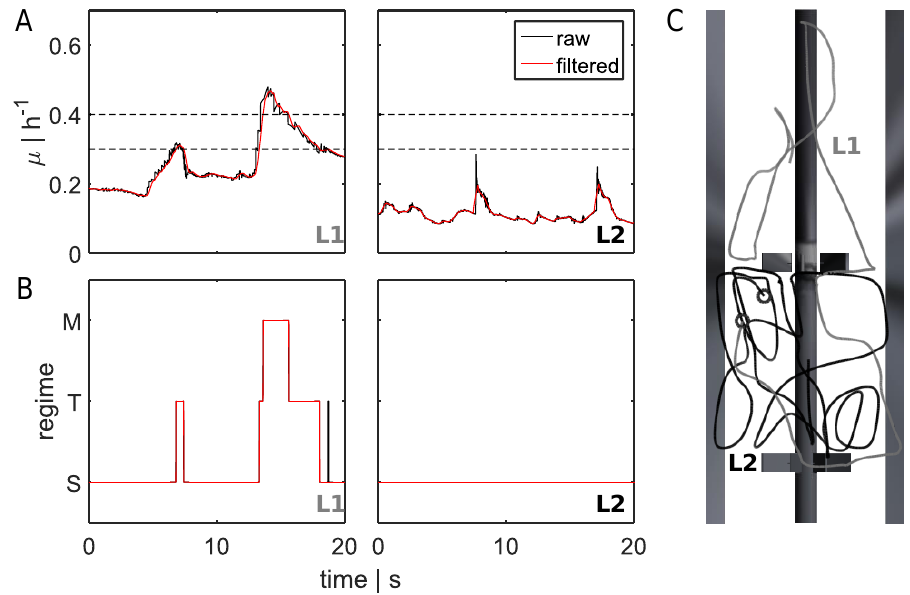
Figure 3. Bacterial lifeline and regime transition classification. ( A ) Two-dimensional (2D) bacterial lifeline for different growth rates μ over time. The black line represents raw data, and the red line represents filtered data (moving average filter to correct discrete random walk (DRW) fluctuations). Black dashed lines indicate the transition regime from single-forked to multiforked replication. ( B ) Translation of filtered (one-dimensional (1D) filter) growth rate curves for the three regimes: multifork replication regime M, transition between standard forked and multiforked T, and standard replication S. Examples for two bacterial lifelines L1 and L2 are depicted. For L1, five regime transitions (STS, TST, STM, TMT, and MTS; see Section 2.3) were analyzed. ( C ) Bacterial movement patterns for two bacterial lifelines (L1 in gray and L2 in black). Starting positions are indicated by black circles.